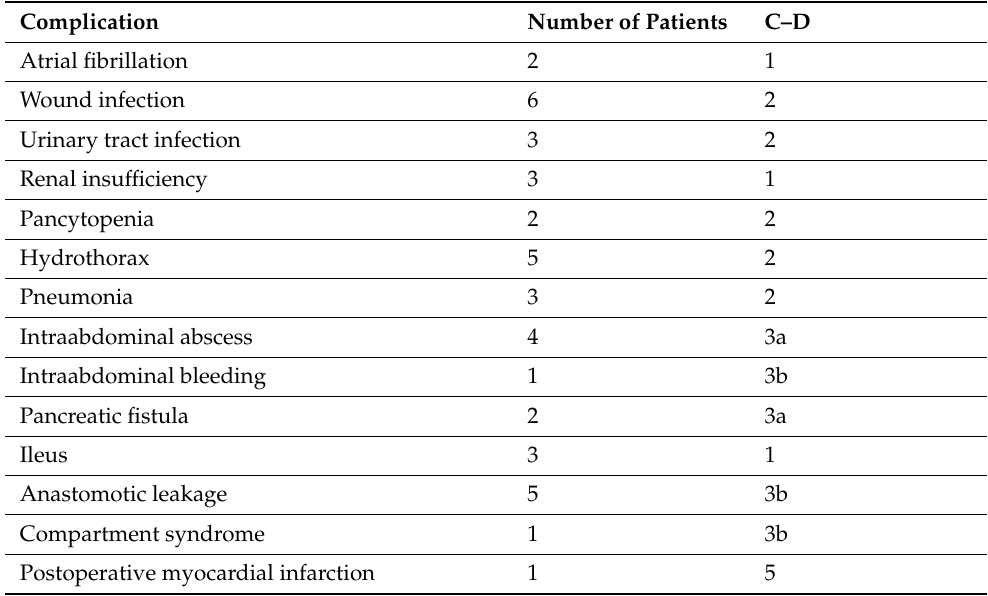
Table 2. Postoperative complications after cytoreductive surgery and hyperthermic intraperitoneal chemotherapy for peritoneal surface